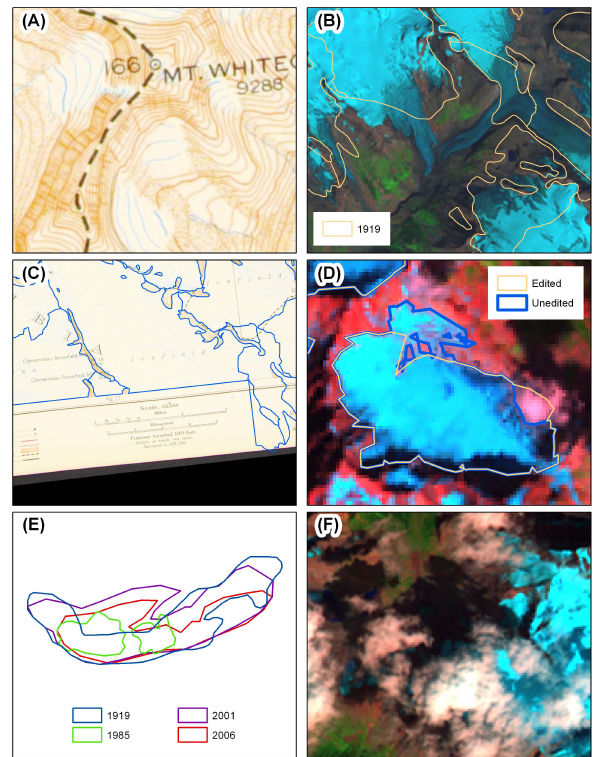
Fig. 4. Errors and problems associated with glacier extents. (A) Off- set 1919 glacier contours. (B) Mismapped 1919 extents. (C) Cut off glaciers. (D) Unedited 2001 extents. (E) Mismapped 1985 and 1919 extents. (F) Shadow and cloud